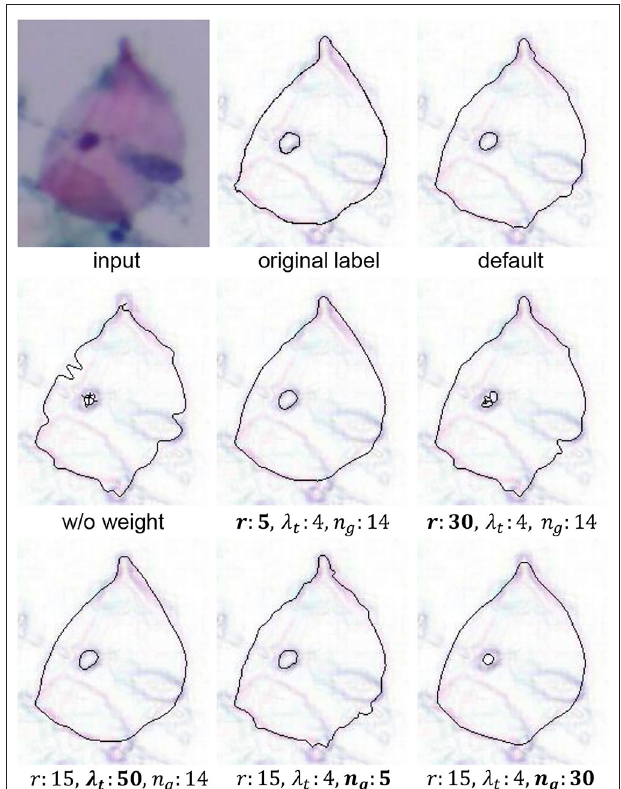
FIGURE 13 | Visual comparison results for different parameters settings in our LLPC. “Default” is r Equation (3).